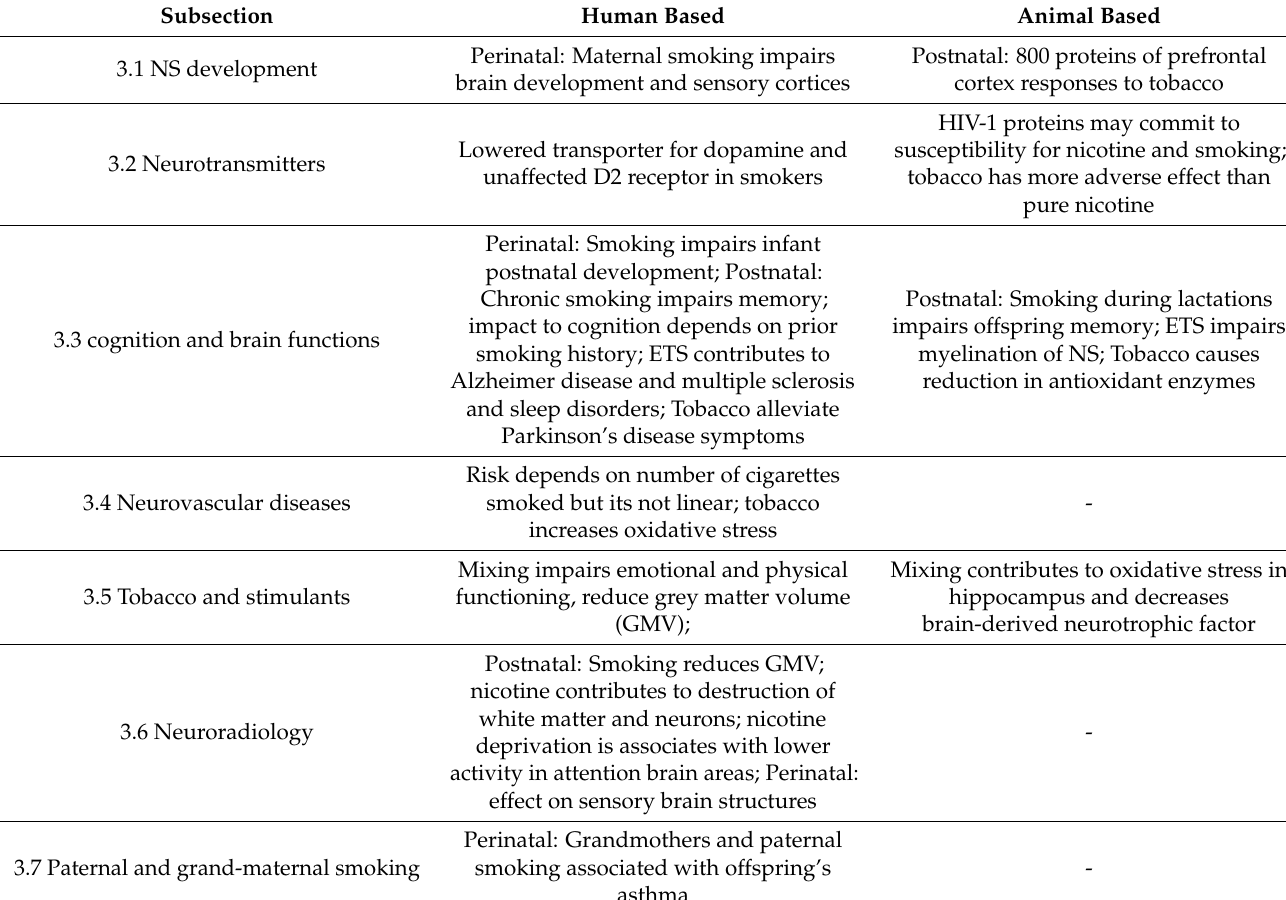
Table 1. Most important findings of this